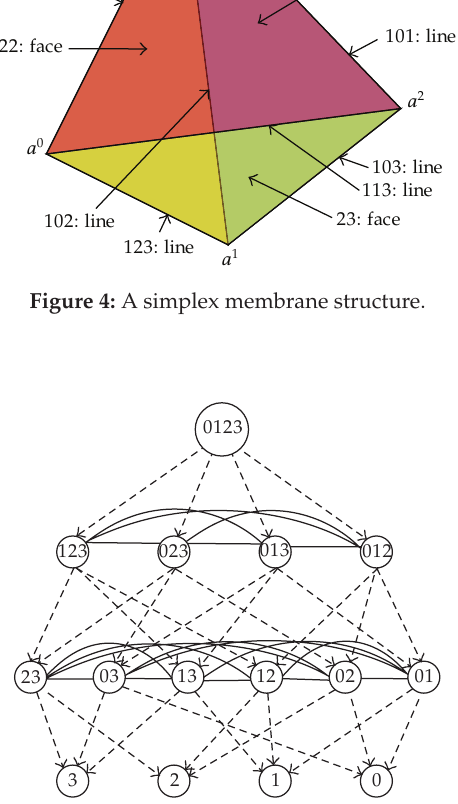
Figure 5: A network model for membrane